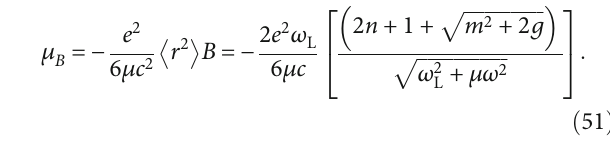
Figure 1: The expectation value of the square of the position r 2 as a function of Larmor frequencies ω g = m = 1 .